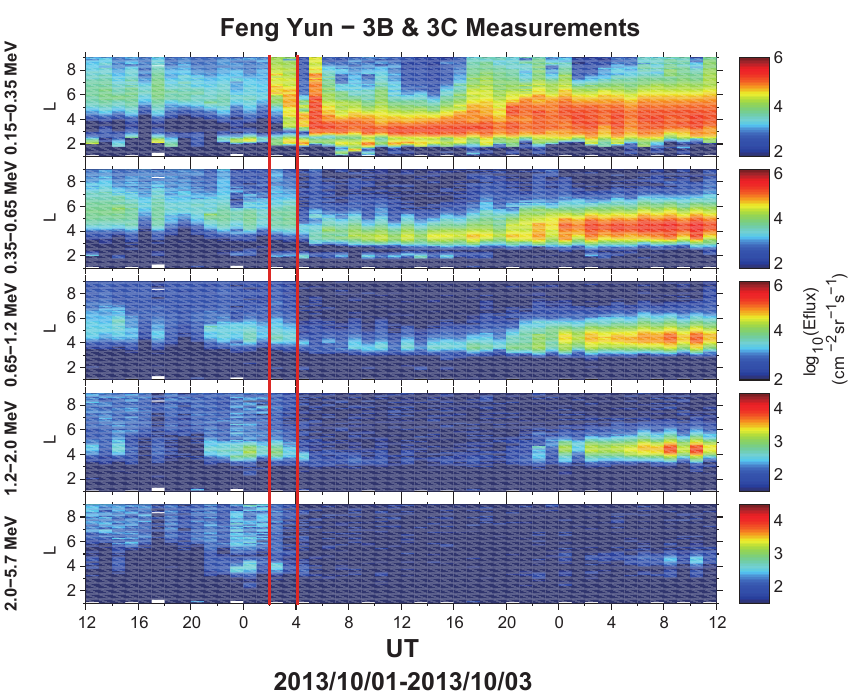
Figure 5. Temporal variations of radiation belt electron flux observed by low-altitude FengYun 3B and 3C spacecraft during the 2-day period for five energy channels, i.e., 0.15–0.35, 0.35–0.65-, 0.65–1.2, 1.2–2, and 2–5.7MeV. The two vertical lines represent the start of the two intense P dyn enhancements. The color scale specifies the logarithmic values of electron